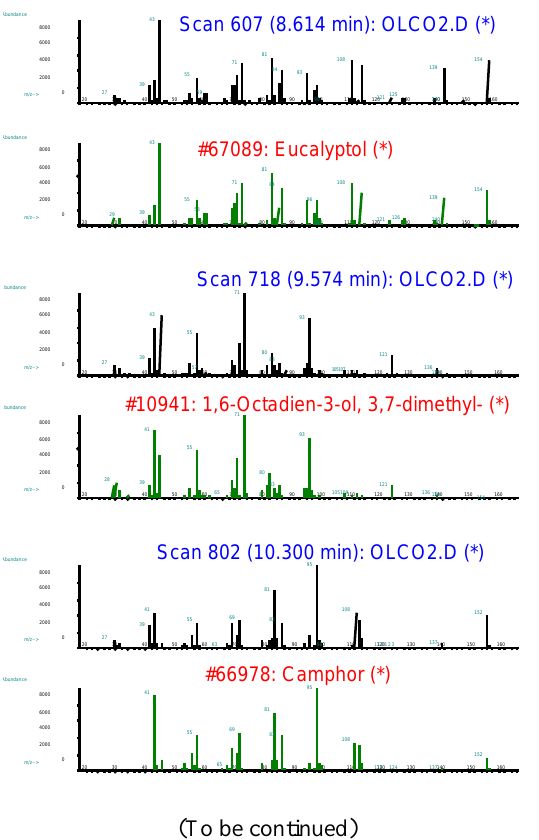
Figure 3. The comparison of mass spectra obtained experimentally in a GC/MS analysis (black, side up each frame) and NIST library spectra (green, down). The identification was made using PBM search from HP MSD